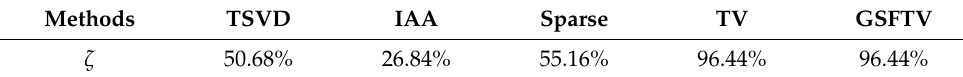
Figure 6. Definition of contour fidelity coefficient (CFC). Table 2. CFCs of simulation results.